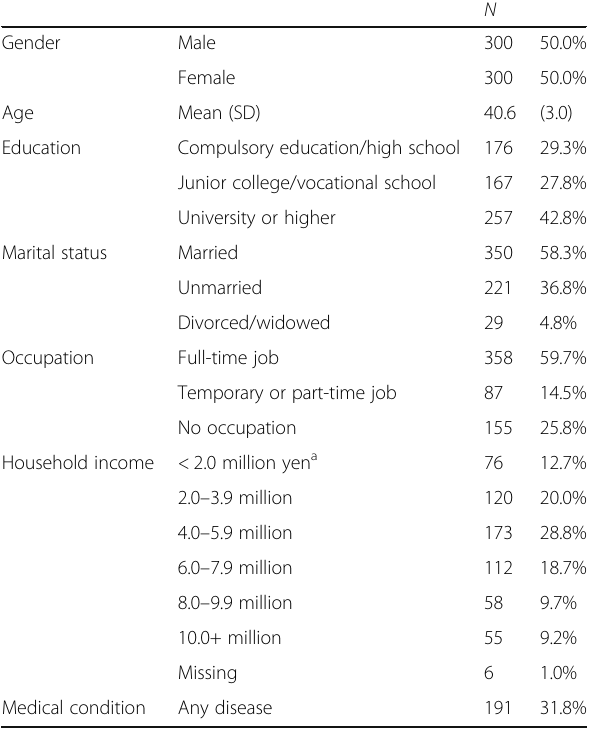
Table 1 Characteristics of the study